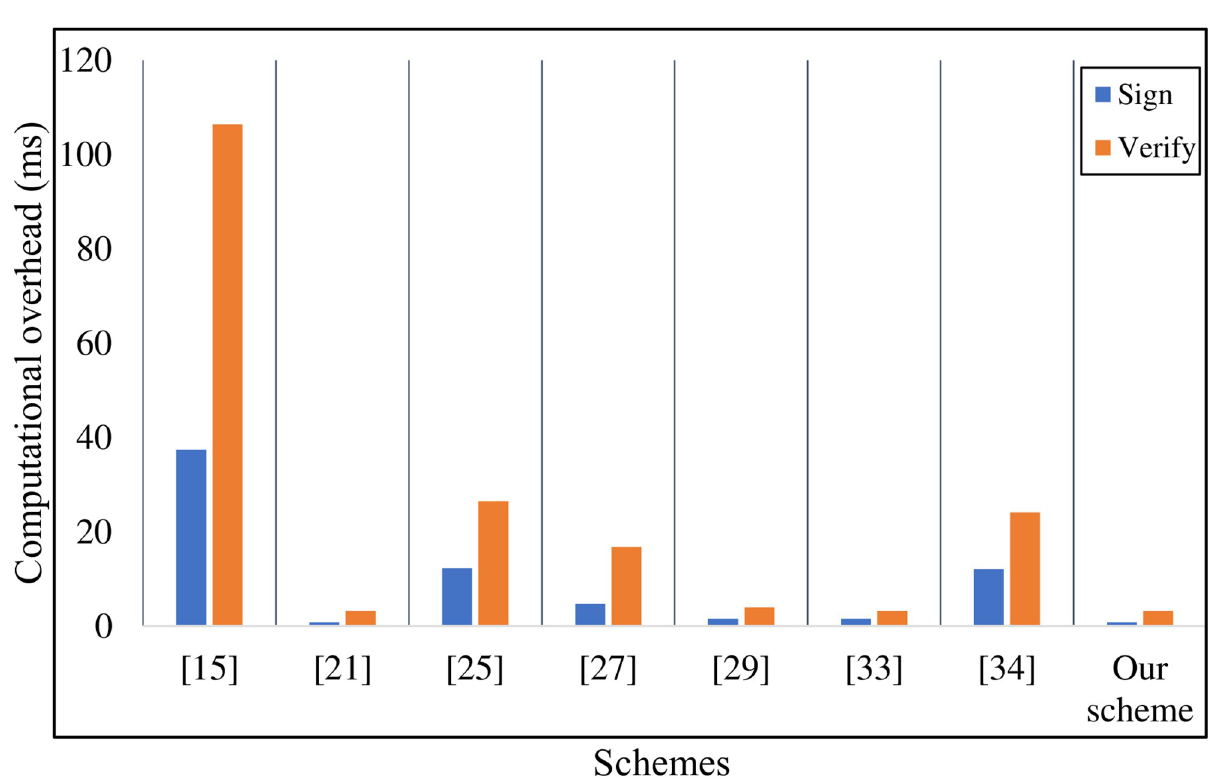
Fig 2. Computational overhead of the single signing and